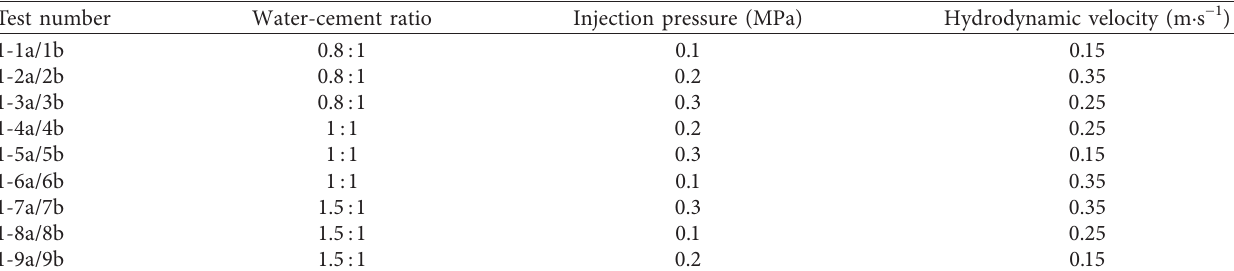
Table 3: Scheme for determining the optimal plugging flow